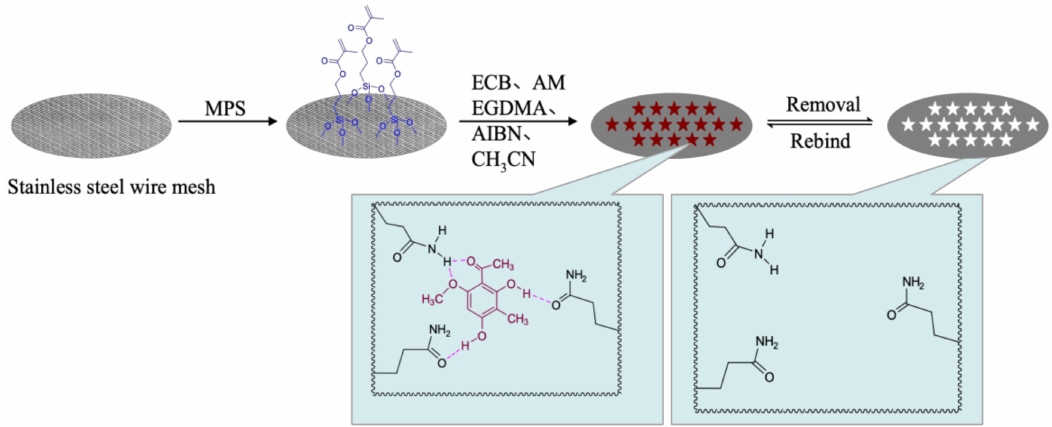
Figure 1. Schematic procedure for formation of a molecularly imprinted composite membrane for selective separation of Ebracteolata Compound B (ECB-MICMs) on a stainless steel wire mesh. MPS: 3-(methacryloyl) propyltrimethoxysilane; AIBN: azobisisobutyronitrile; EGDMA: ethylene